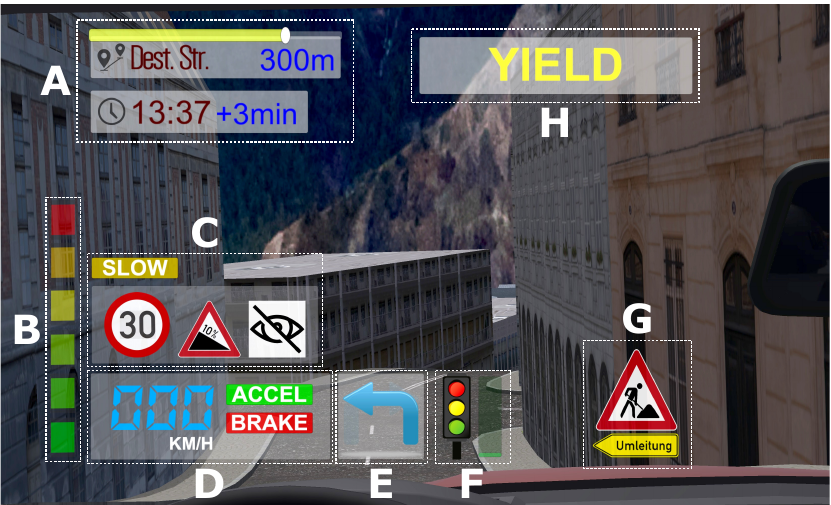
Figure 2. All screen-fixed elements of the WSD interface. Dynamic elements are showing example content not necessarily applying to the depicted driving scene, best viewed in